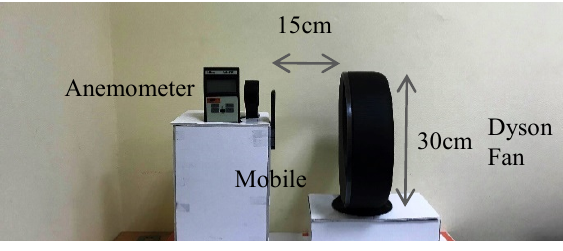
Figure 3. Experimental Setup.